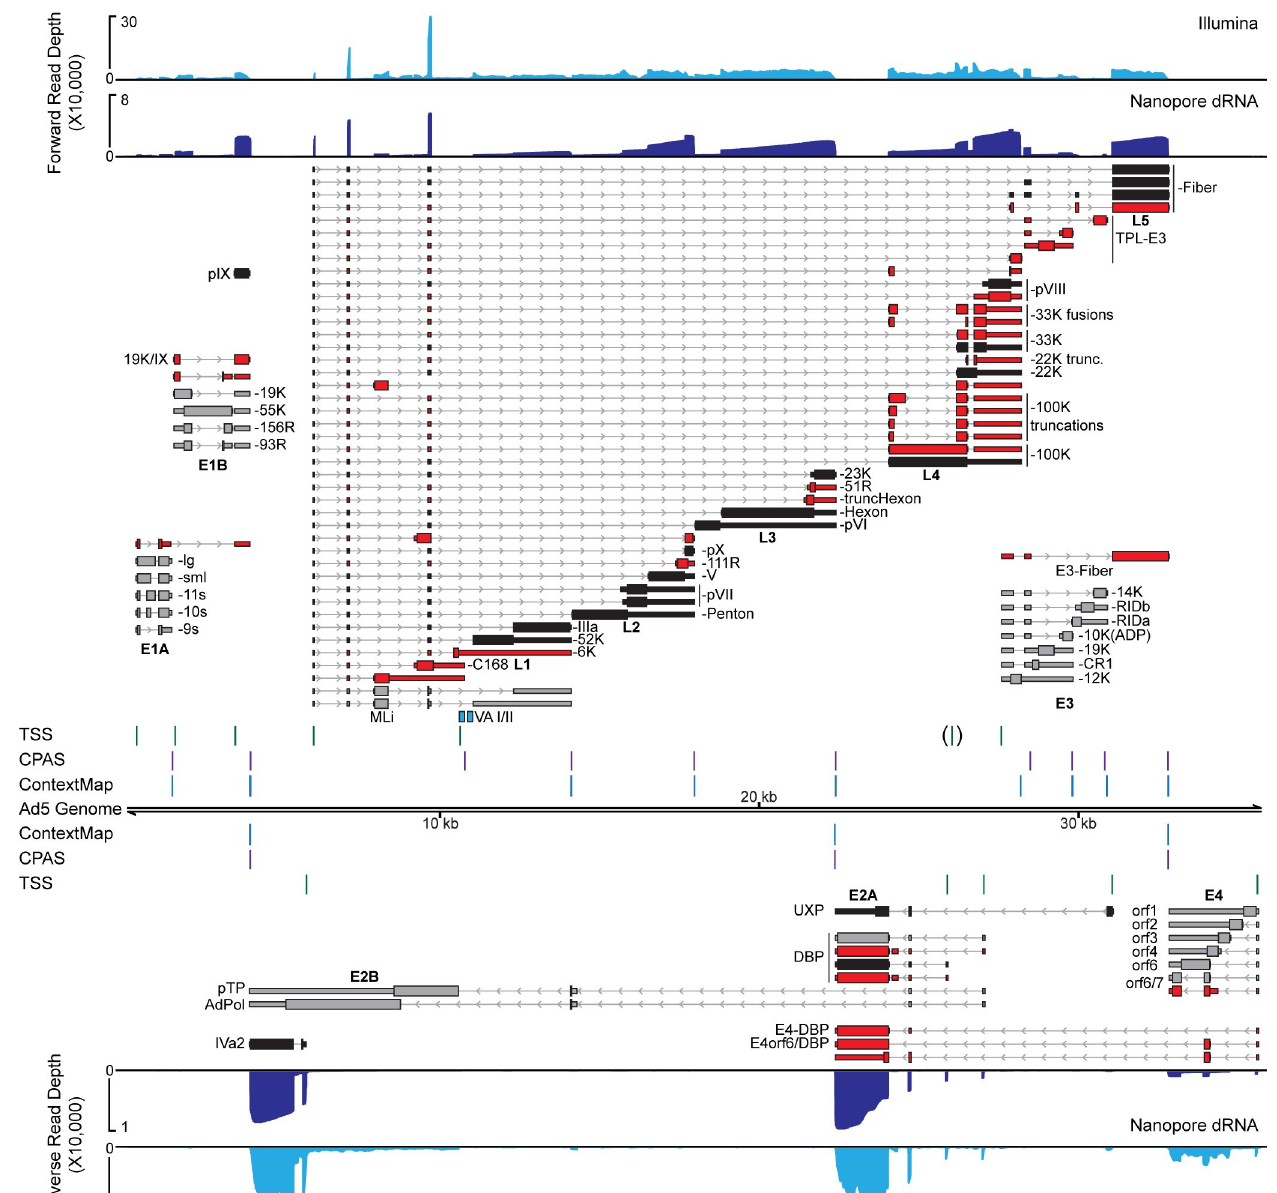
Fig 2. Combined short-read and long-read sequencing showcases adenovirus transcriptome complexity. A549 cells were infected with Ad5 for 24 hours before RNA was extracted and subjected to both short-read and long-read sequencing. Sequence coverage provided by short-read stranded RNA-seq (Illumina, light blue), as well as nanopore long-read direct RNA-seq (Nanopore dRNA, dark blue), is shown along the Ad5 genome. For both tracks, reads aligning to the forward strand are plotted above the genome, while reads aligning to the reverse strand are shown below the genome. For dRNA-seq datasets, reads can be reduced to their 5’ and 3’ ends and peak-calling applied to predict individual transcription start sites (TSS, green vertical lines) or cleavage and polyadenylation sites (CPAS, magenta vertical lines), respectively. The TSS for the L4 promoter was only detected at 12 hpi and is thus displayed in brackets. Similarly, the ContextMap algorithm can predict, albeit at lower sensitivity, CPAS sites from poly(A) containing fragments within Illumina RNA-seq data (ContextMap, light blue vertical lines). Individual RNA transcripts are shown above and below the genome, with thin bars denoting 5’ and 3’ untranslated regions (UTR), thick bars denoting open reading frames (ORFs), and thin lines with arrowheads denoting both introns and orientation of transcription. Previously characterized early genes are denoted in grey, while previously characterized late genes are denoted in black. RNA isoforms discovered in this study are highlighted in red. Names of transcriptional units are shown under each cluster of transcripts, while the name of the protein derived from the respective ORF is listed after each transcript to the right or left. The position of Pol III-derived noncoding RNAs virus associated VA-I and VA-II are highlighted in teal